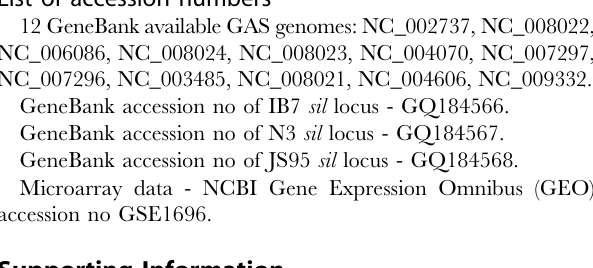
Figure S1 The dependence of P 4 activity on SilCR concentration in the GAS JS95 and GGS N9 strains. To calculate promoter activity, JS95 (A) or N9 (B) harboring p P 4 -gfp were grown to OD 600 =0.2, then SilCR was added to the indicated concentrations and the cultures were further incubated for 1 h. Fluorescence intensities were determined at time 0 and then every 15 min as described in ‘‘Materials and Methods’’. The slopes of fluorescence intensity as a function of time (representing initial rates of GFP accumulation) were calculated by performing least square analyses which yielded coefficients of determination greater than 0.95 (R 2 . 0.95) and depicted here as promoter activity. The values shown are the mean 6 the standard deviation results of at least two independent experiments. Figure S2 The silE-blpM intergenic region. The sequence between silE and blpM start codons (red letters and arrows) is shown. DR1 and DR2 sequences are marked in blue. Transcrip- tion start sites are indicated by yellow circles [12]. Primers used for construction of p P 3 -gfp and p P 4 -gfp are indicated by black bended arrows. The location of exonuclease III digestion stop points, described in Figure 2D and in ‘‘Materials and Methods’’, are pointed by numbered rectangles. Figure S3 Analysis of the transcript initiated from the P6 promoter